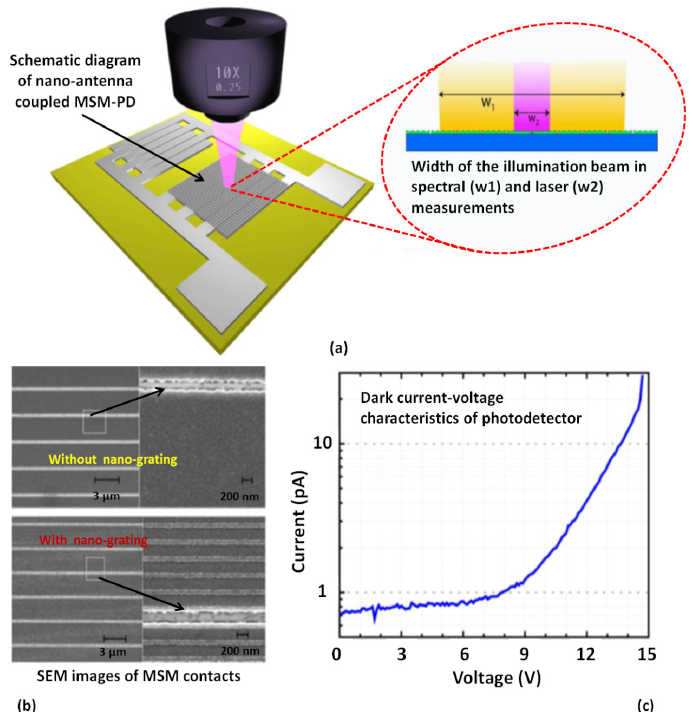
Figure 5. The concept, development, and characterization results of metal-gratings based nano-an- tenna that integrated into the detector for photocurrent enhancement. The schematic diagram of Al- nano-grating base nano-antenna coupled with MSM-PD (a) , SEM images of developed contacts (b) , and the measured dark-current performance (c) [8,75]. The figure has been reproduced with per- mission from [Ref 75] © The Optical Society.